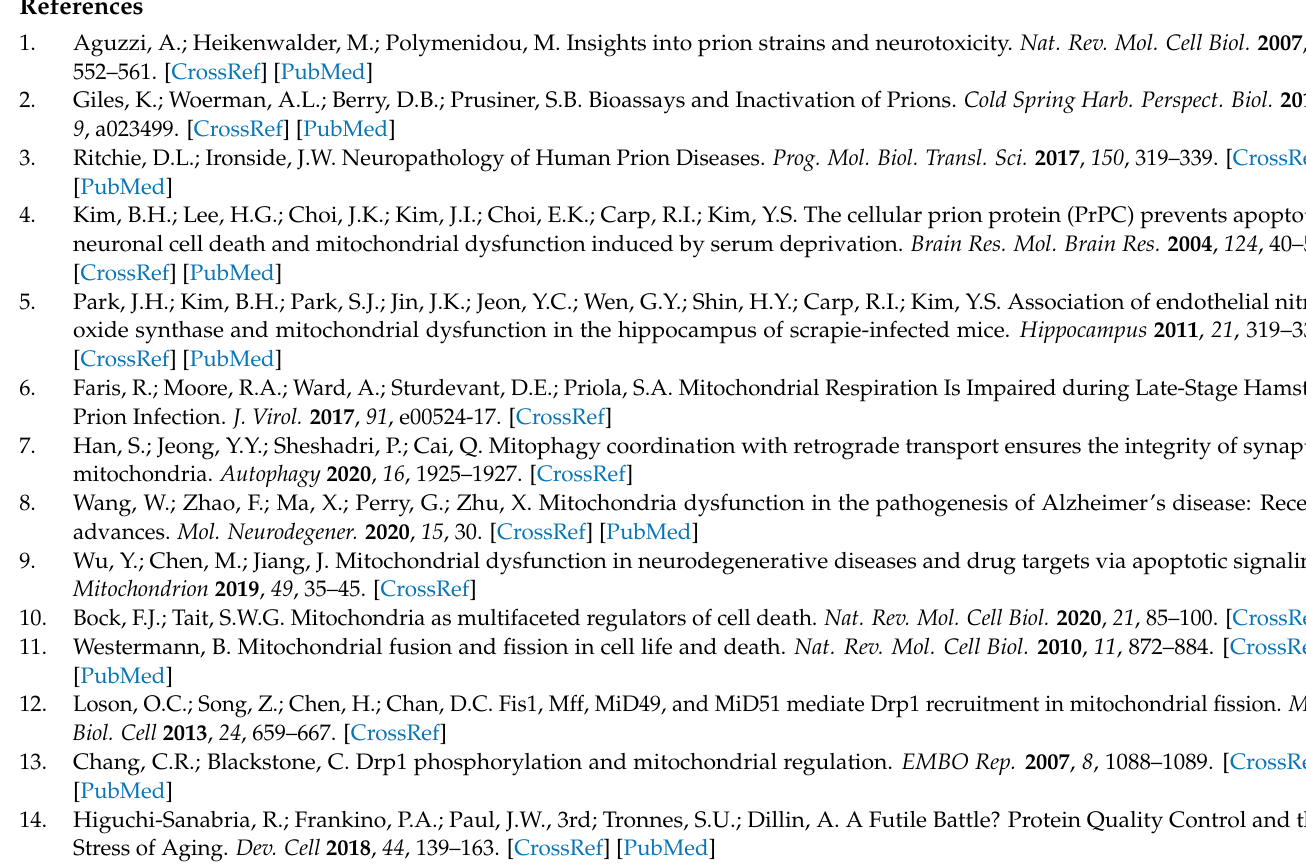
Figure S3. RhoA/ROCK activity is involved in mtROS generation and ∆Ψ m in 22L scrapie-infected CxN cells; Figure S4 Scrapie infection induced mitophagy in the brains of 22L scrapie-infected